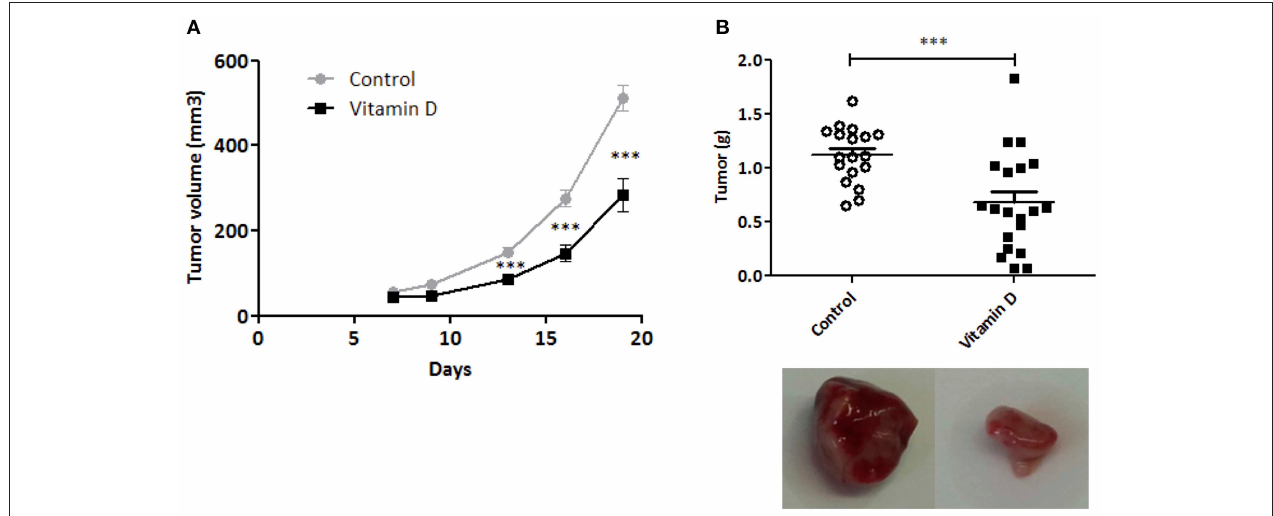
FIGURE 1 | Vitamin D limits EO771 tumor progression in mice. EO771 cells were injected in the fat pad of the mammary glands ( n = 8–10) of female mice fed with standard diet. (A) Tumor size was measured with a caliper. The values of tumor volume (mm 3 ) are reported (Mean ± SEM). (B) Tumors were weighed at the end of the experiment (g). Statistical significance between control and VD groups was determined by two-tailed Student’s t -test. *** P < 0.001.